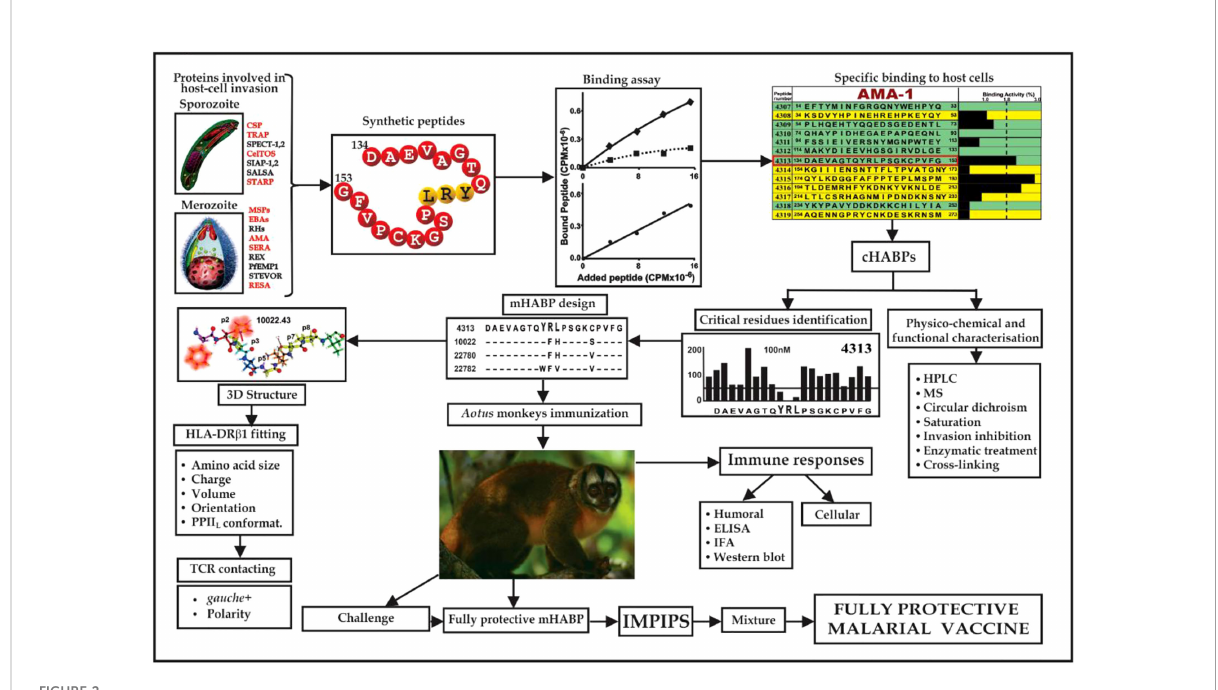
FIGURE 2 Flowchart for fully-protective malaria vaccine development, based on elegant work by other groups and in-depth reviews (4, 11, 14). Spz- and Mrz-derived proteins ’ aa sequences relevant in P. falciparum invasion; 15-20-mer cHABP synthetic peptide evolution for developing a protective, minimal subunit-based, multistage, multiepitope anti-malarial vaccine, following established stereo-electron principles (3, 5, 15) (Taking from Ref.